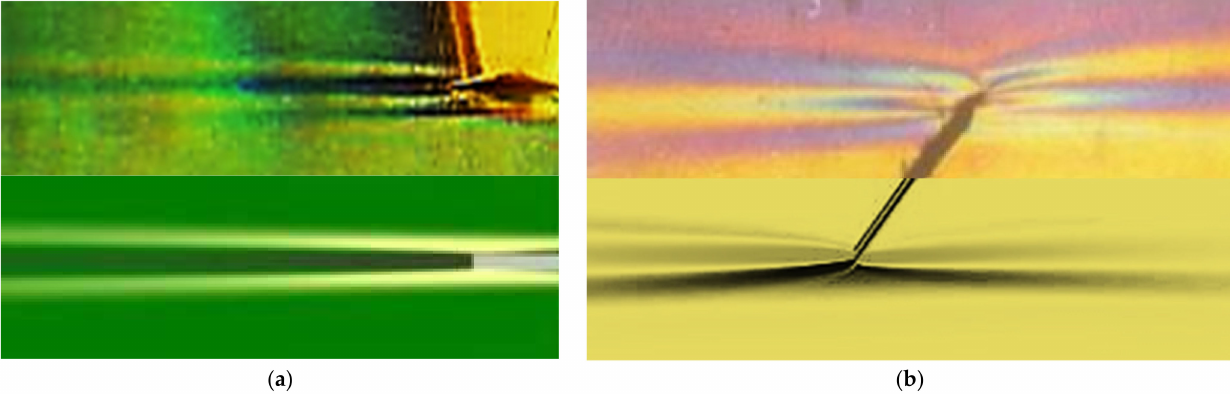
Figure 4. Schlieren (upper part of the images) and calculated (lower one) diffusion-induced flow patterns on motionless horizontal and tilted plates ( L = 2.5 cm, T b = 7.6 s): ( a , b )— α = 0.40 ◦